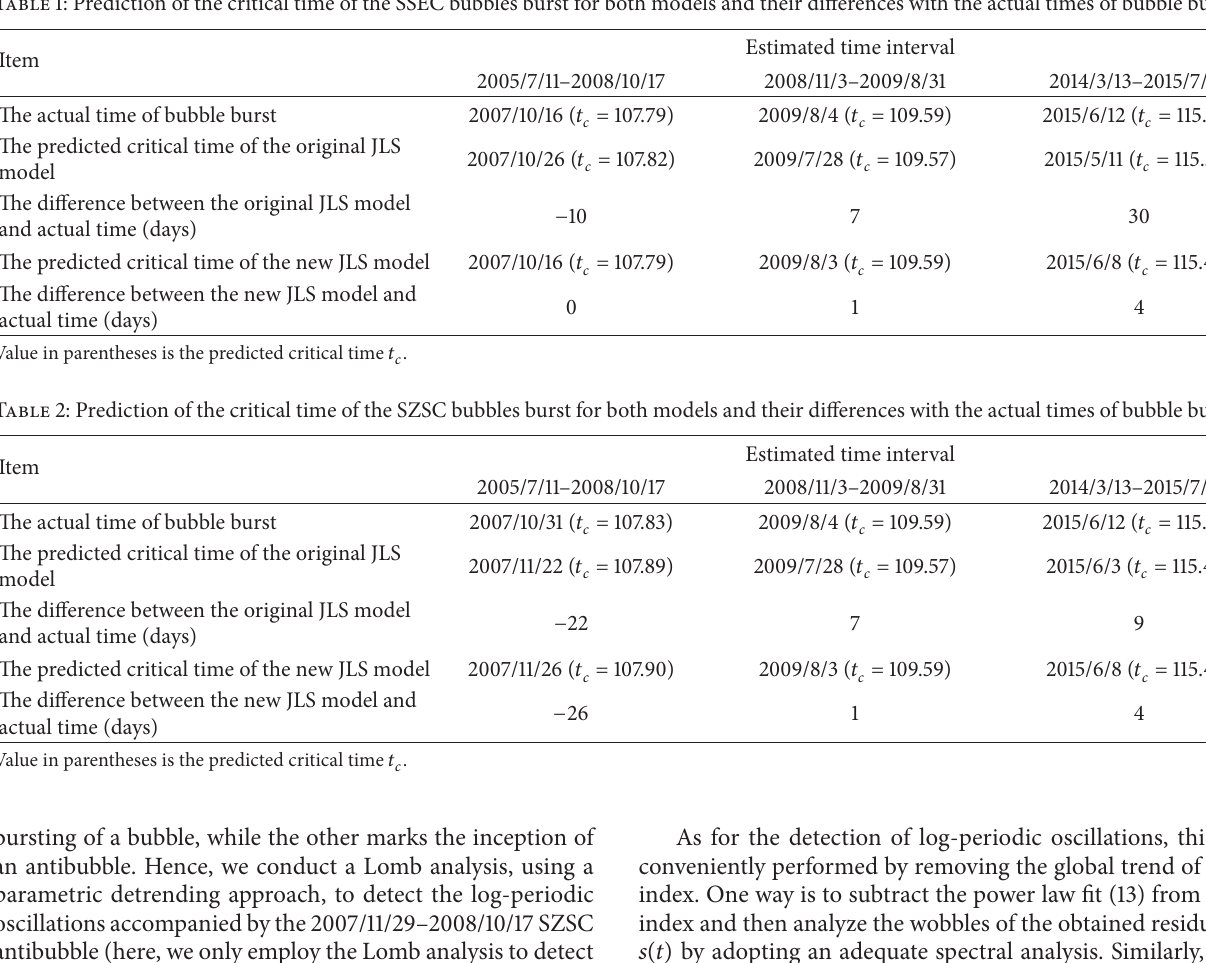
Table 1: Prediction of the critical time of the SSEC bubbles burst for both models and their differences with the actual times of bubble burst. Item